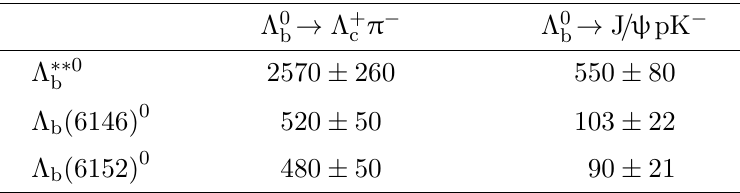
(cid:25)(cid:25) spectra with (cid:3) 0 b